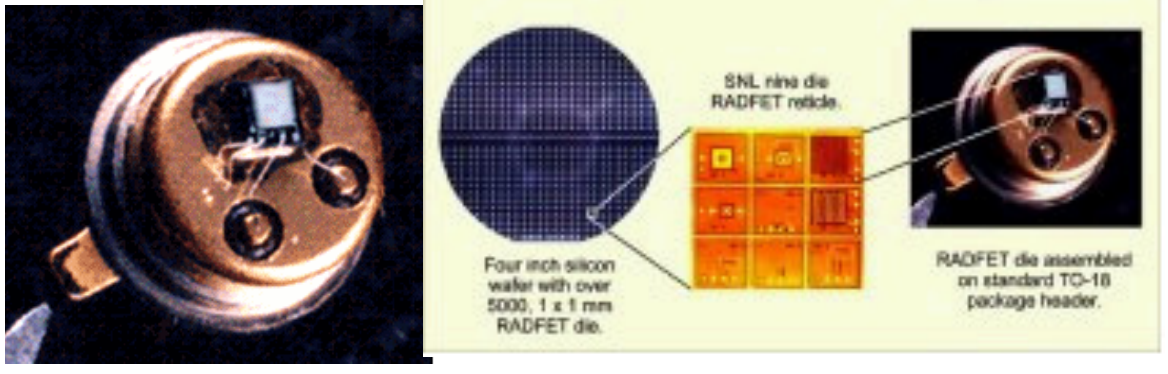
Figure 2. The 1 mm 2 RadFET element fits on a standard TO-18 package header. Over 5000 RadFETs can be microfabricated on a single 4 inch